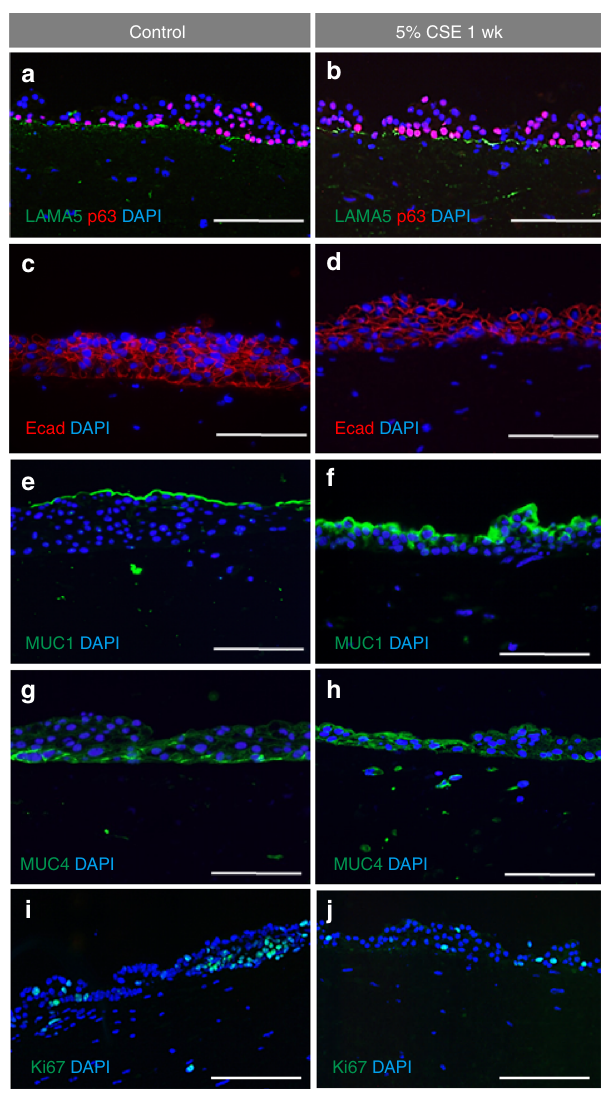
Fig. 9 Changes in expression structural and functional genes after 5% CSE exposure for 1 week. a , b Double immuno fl uorescent staining for expression p63 (red) and Laminin alfa 5 (green) in control VF mucosa ( a ) and CSE VF mucosa ( b ). c , d Immuno fl uorescent staining comparing the expression of E- Cadherin (red) in control VF mucosa with slightly more intense staining in the basal cell layer ( c ) and CSE treated VF mucosa ( d ). e , f Immuno fl uorescent staining comparing the expression of MUC1 (green) in control VF mucosa ( e ) with more intense MUC1 staining in the CSE VF mucosa ( f ). g , h Immuno fl uorescent staining comparing the expression of MUC4 (green) in control VF mucosa ( g ) with a slightly more intense MUC4 staining in the CSE VF mucosa ( h ). i , j Distribution of Ki67 + VFEC and VFF in control VF mucosa ( i ) and CSE exposed VF mucosa ( j ).